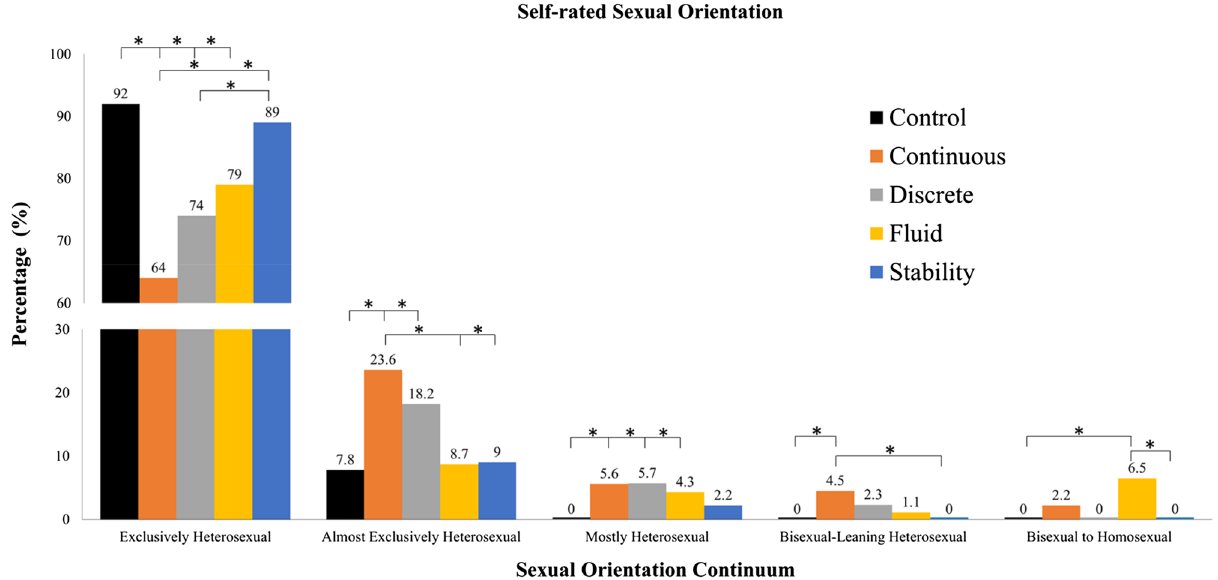
Figure 2. Sexual orientation self-ratings from Exclusively Heterosexual through to Exclusively Homosexual after reading a control article or a continuous, discrete, fluid, or stable account of sexual orientation. Differences in sexual orientation * p <